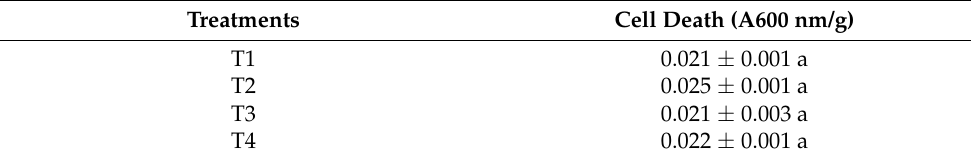
Table 4. Effects of endophytic B. bassiana on cell death following exposure to pathogenic FOL. Treatments